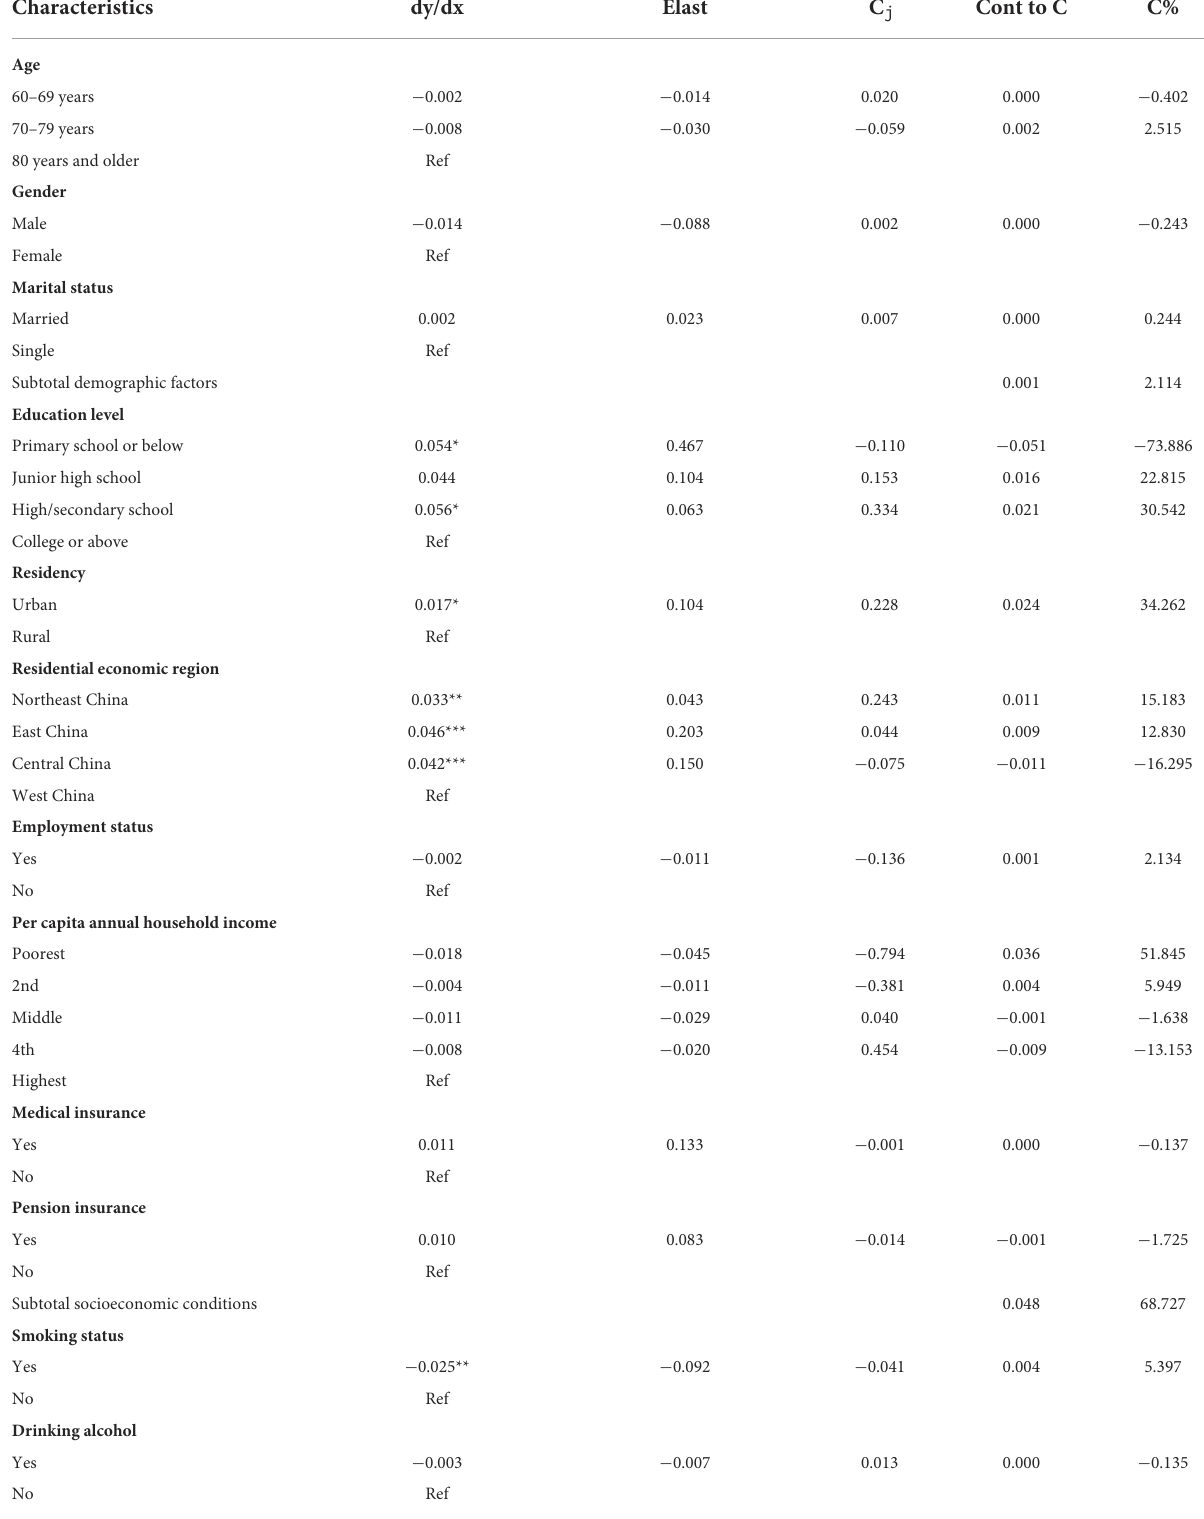
TABLE 2 Decomposition of concentration index in obesity among the elderly in China. Characteristics dy/dx Elast C j Cont to